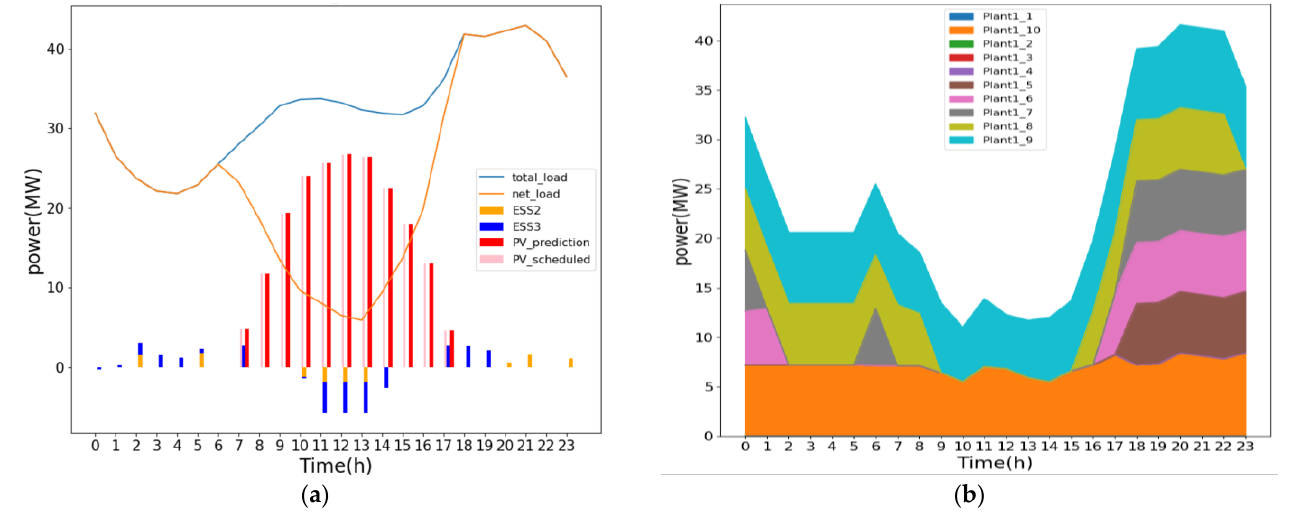
Figure 9. Case 1: result of first ED of ( a ) PV generation and the charge and discharge of ESS and ( b ) the power output of the diesel generators.